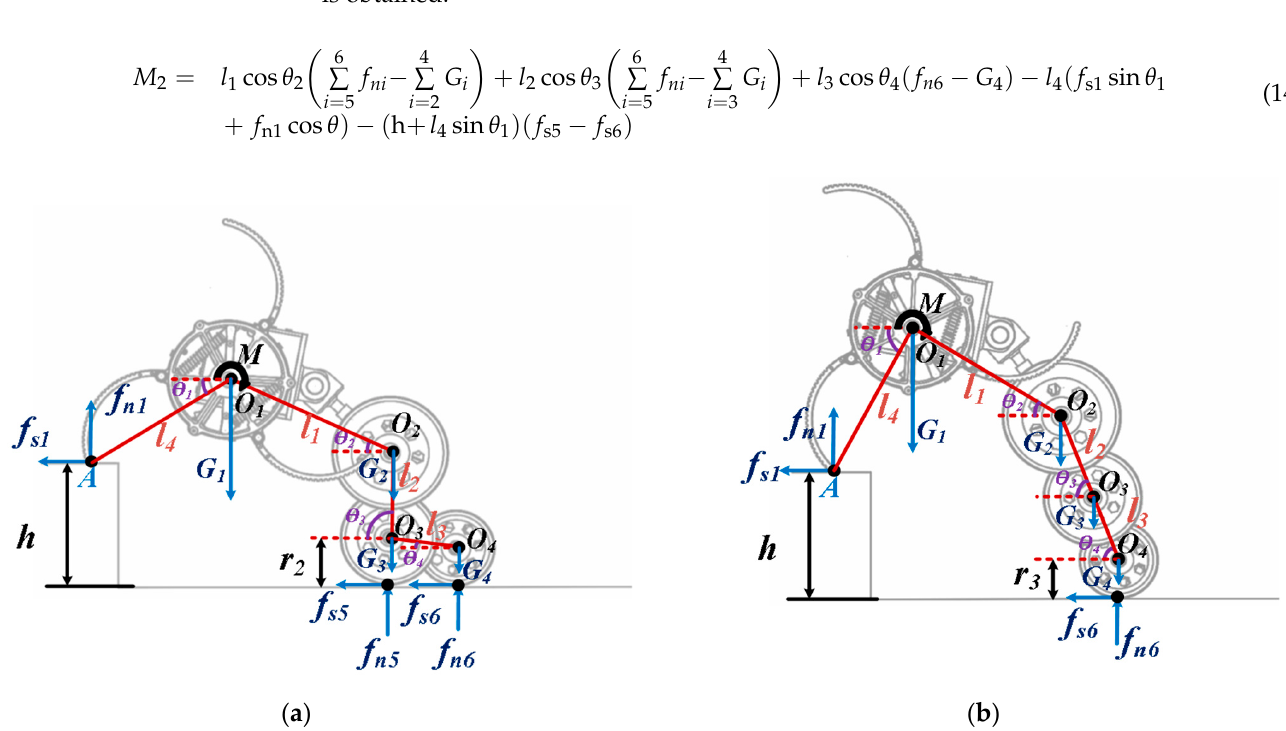
Figure 12. Moving through vertical obstacles stages II and III. ( a ) stage II; ( b ) stage III.